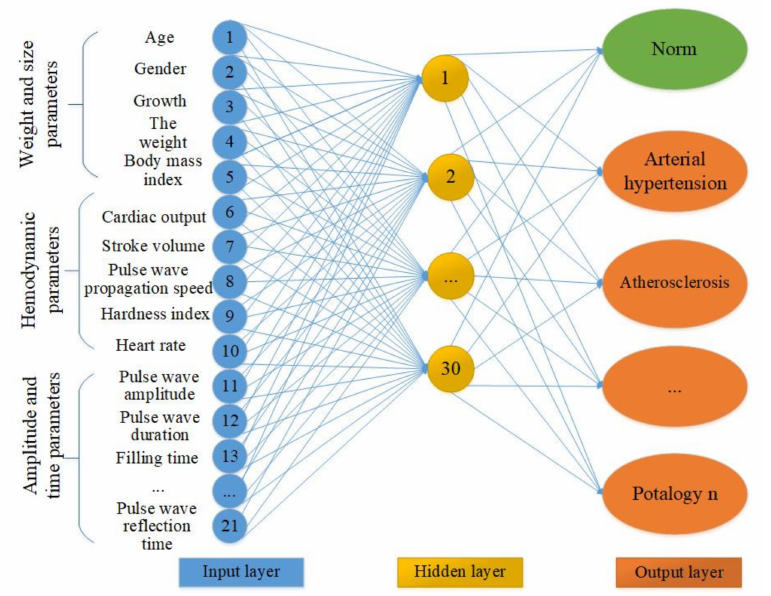
Figure 9. The neural network architecture variant. The under development neural network con- tains three groups of data in 21 input neurons. The hidden layer and the output layer with pathological conditions.